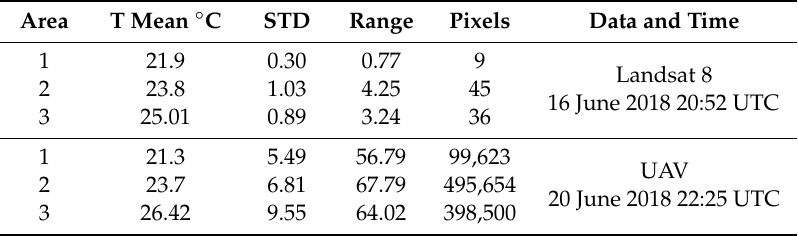
Figure 9. Maps of land surface temperature of UAV ( A , C , E ) and Landsat 8 ( B , D , F ) over the TINITALY digital elevation model [42–44]. Table 4. Statistical analysis for June